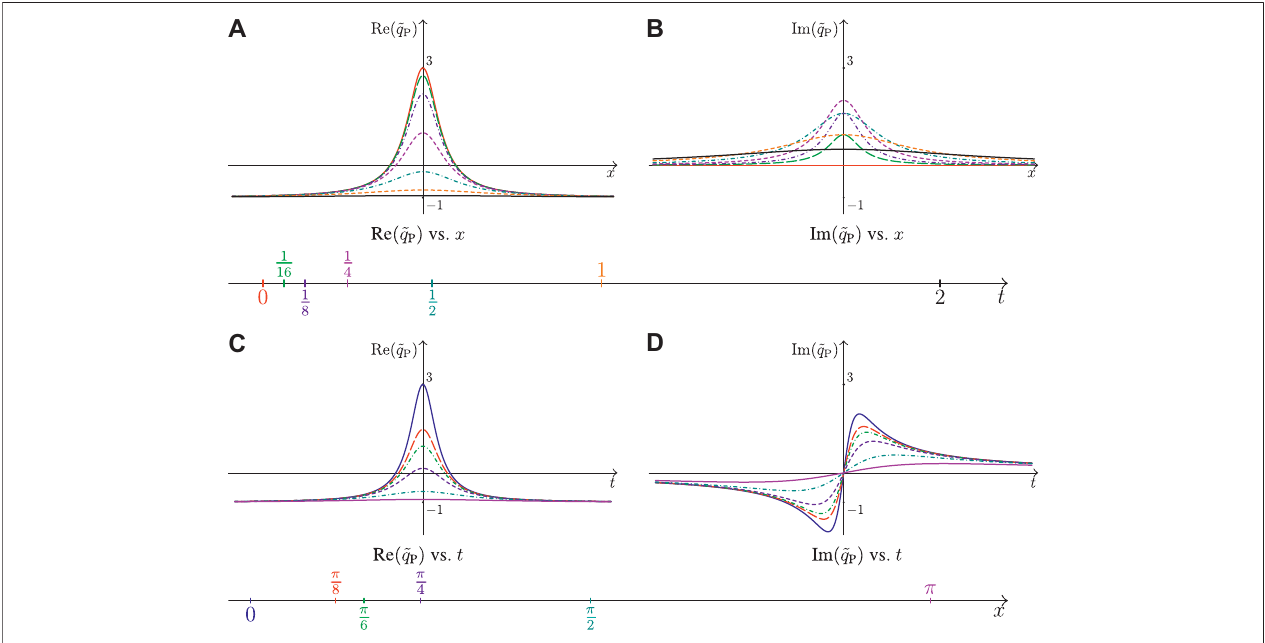
FIGURE 8 | Plots of the real and imaginary parts of the non-rapid oscillating complex-valued amplitude for the Peregrine soliton with respect to the spatial and temporalvariables, x (upperpanels)and t (lowerpanels),respectively.Forupperpanels (A) and (B) ,variouscurvesindicatesdifferenttime: t (cid:2) 0(solidred), t (cid:2) 1 / 16(long- dashed green), t (cid:2) 1 / 8(dash-dotted purple), t (cid:2) 1 / 4(dash magenta), t (cid:2) 1 / 2 (dash-dotted cyan), t (cid:2) 1 (dashed orange), and t (cid:2) 2 (solid black). Forlower panels (C) and (D) , different curves indicates differentpositions: x (cid:2) 0(solid blue), x (cid:2) π / 8(long-dashedred), x (cid:2) π / 6(dash-dotted green), x (cid:2) π / 4(dashedpurple), x (cid:2) π / 2(dash- dotted cyan), and x (cid:2) π (solid